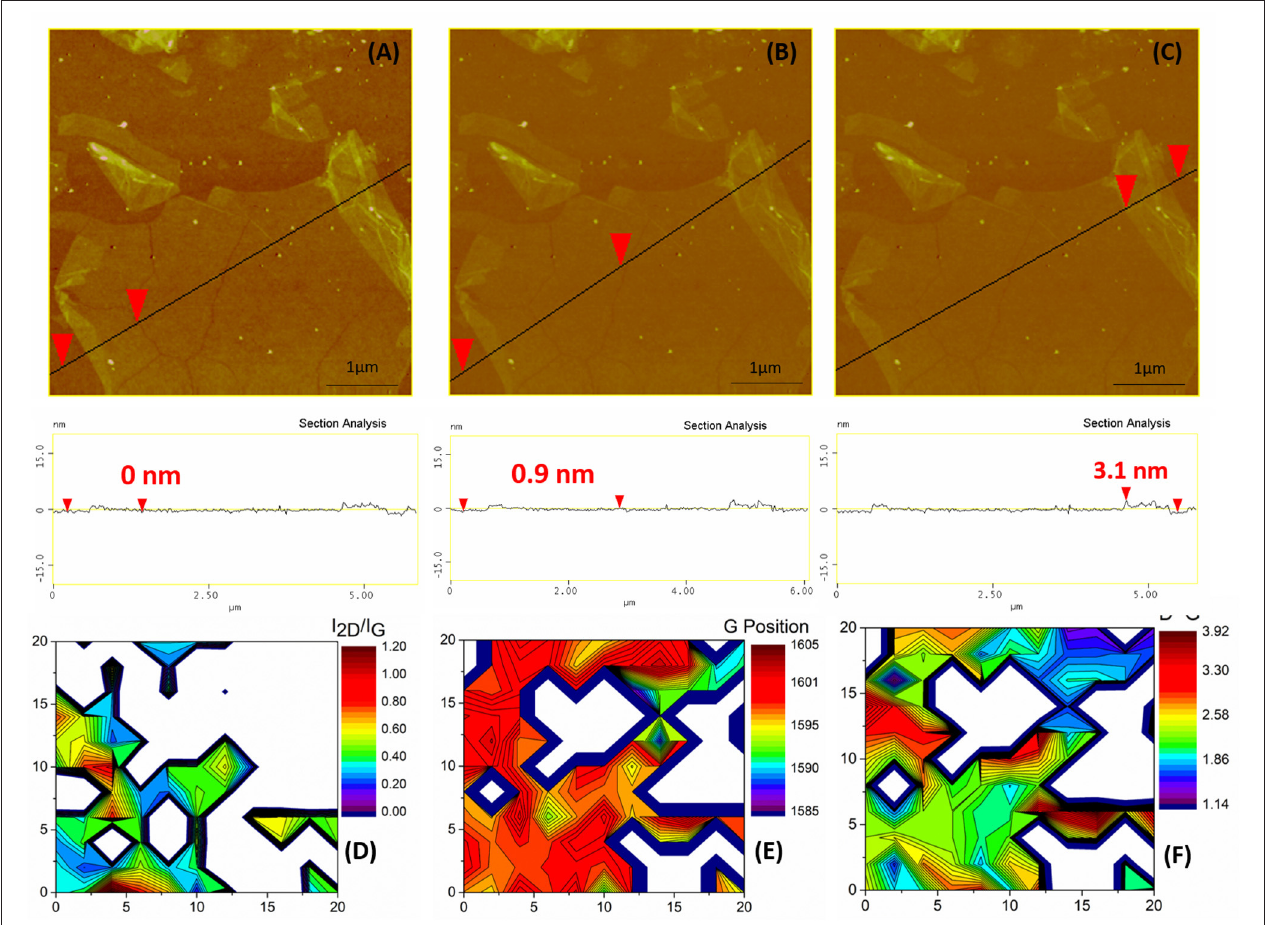
FIGURE 7 | a-G flakes onto the Si substrate. (A–C) top: High magnification AFM image of a cross section, black line, with the red arrows indicating the point of measurement in each case. (A–C) bottom: The section analysis with the respective height measurements. (D) Raman 2D contour plot of the I 2D /I G . (E) Raman 2D contour plot of the G position. (F) Raman 2D contour plot of the I D /I G ratio. Axis dimensions in all Raman plots are in µ